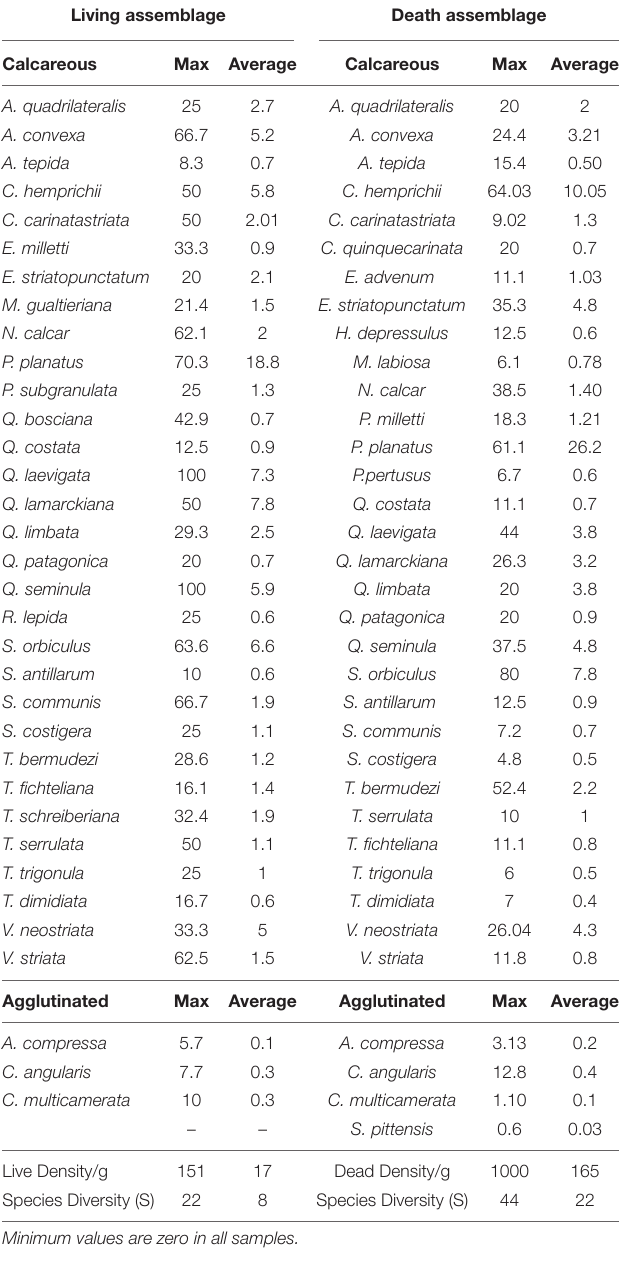
TABLE 4 | Summary statistical parameters of the transfer function of dead foraminiferal training sets using the Weighted Average Partial Least Squares regression (WA-PLS) method for the training data set ( N =